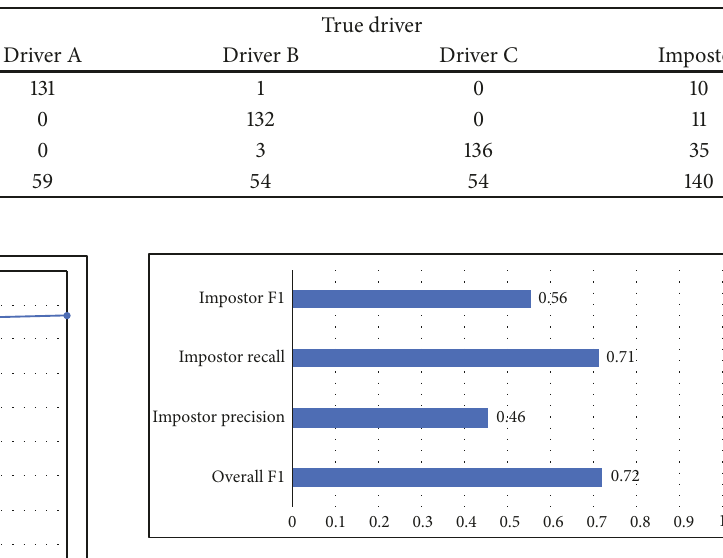
Figure 17: Plot of overall F1, impostor precision, impostor recall, and impostor F1 when utilizing the neural